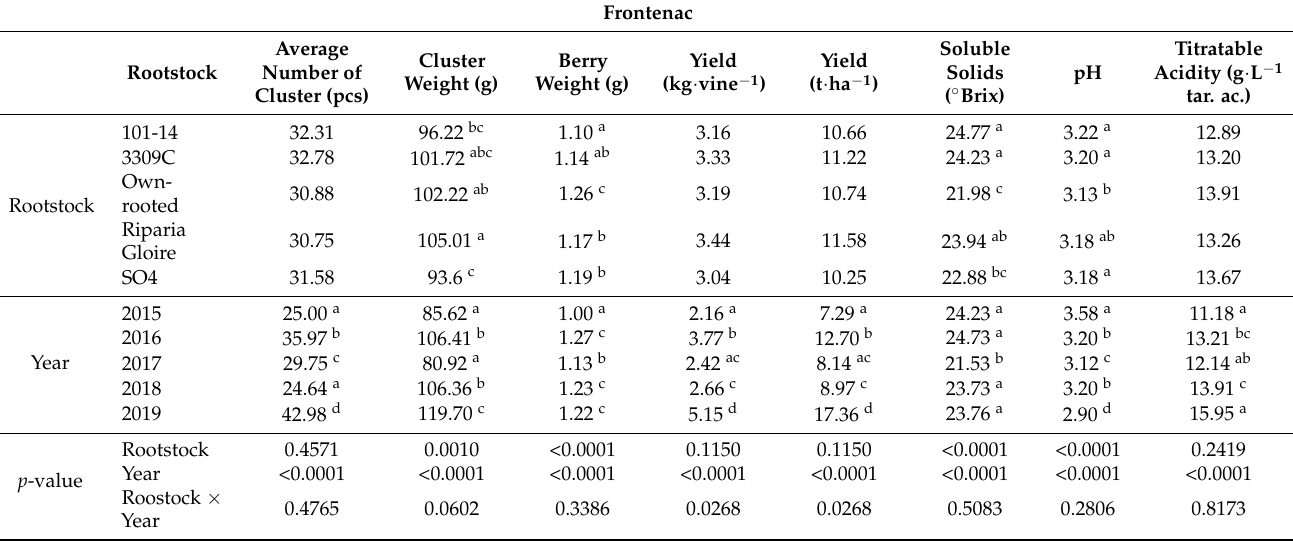
Table 7. Effect of rootstock on yield quantity and fruit composition of grapevine